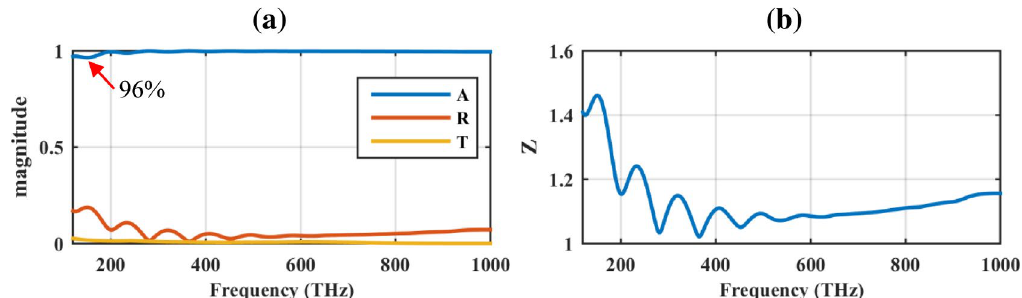
Figure 3. ( a ) The absorbance ( A ), reflectance ( R ), and transmittance ( T ) of the designed solar cell and ( b ) its retrieved surface